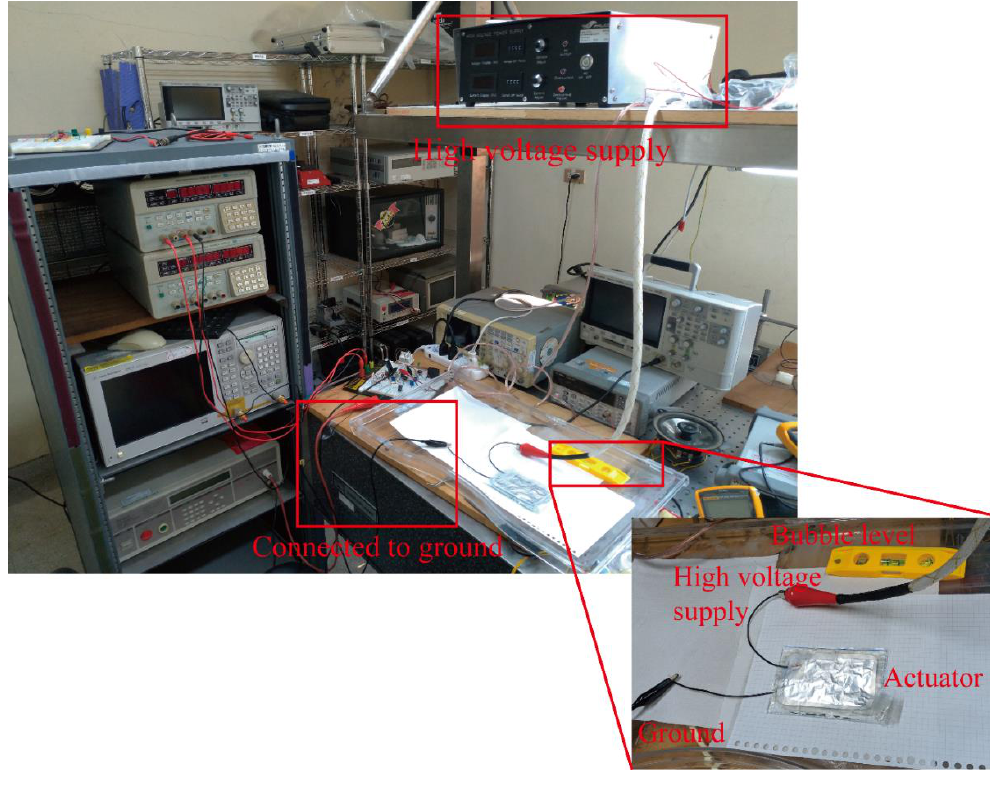
Figure 9. The experimental setup for the BSPA.